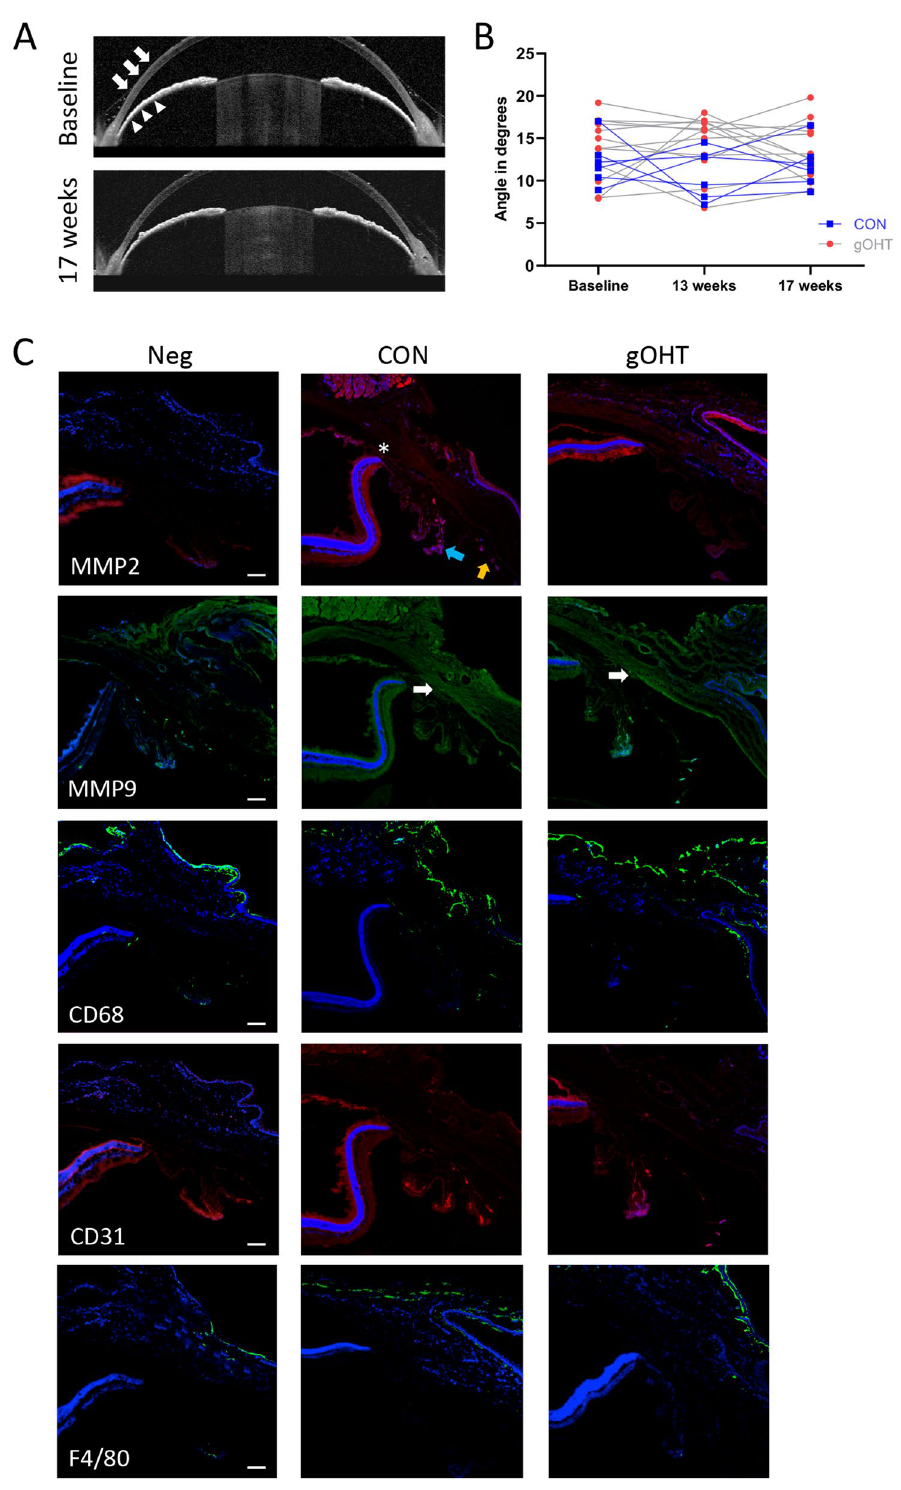
Figure 6. There is no notable change in angle appearance or pathology between CON and gOHT eyes. ( A ) Representative OCT images of the anterior chamber angle show the same eye at the area between the peripheral cornea (arrows) and iris (arrowheads). The angle remained open until the last follow-up after 17 weeks post- suturing. ( B ) Line graphs indicate that the anterior chamber angle did not significantly change over time in either CON or gOHT groups. ( C ) A panel of relevant immunofluorescent markers indicates no significant differences in staining between CON and gOHT angles for MMP-2, MMP-9, CD68, CD31 or F4/80 staining (scale bars indicate 50 μm, all images are shown in the same orientation; the white asterisk indicates the ora serrata, blue arrow points to the ciliary processes, orange arrow to the iris and white arrows to Schlemm’s